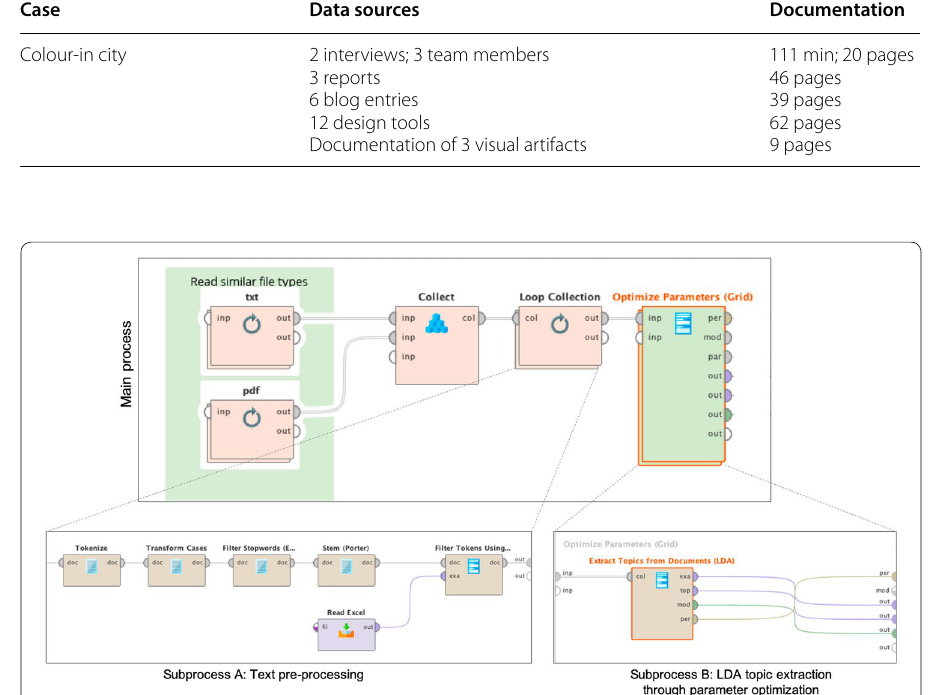
Fig. 2 RapidMiner process and